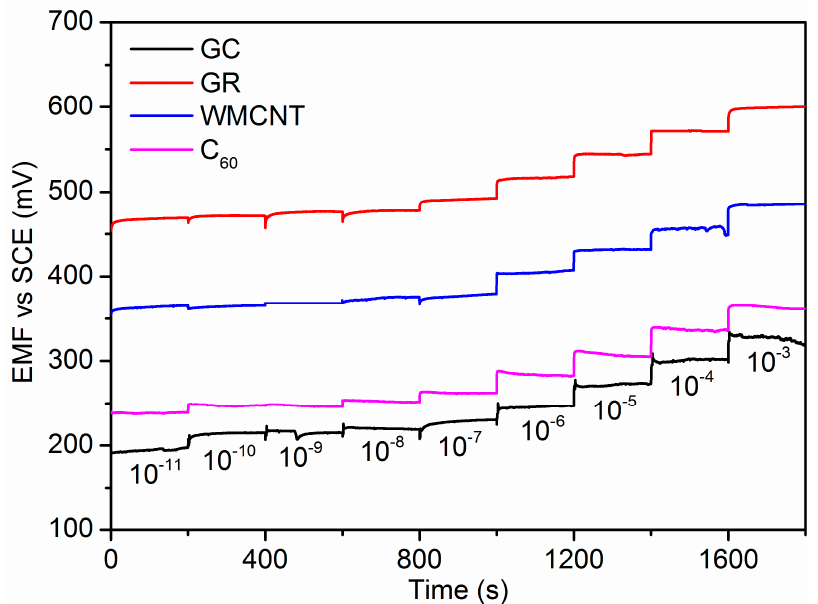
Figure 4. Potentiometric response of the different Pb 2+ -ion-selective electrodes (ISEs) with lead concentrations from 10 − 11 to 10 − 3 M.